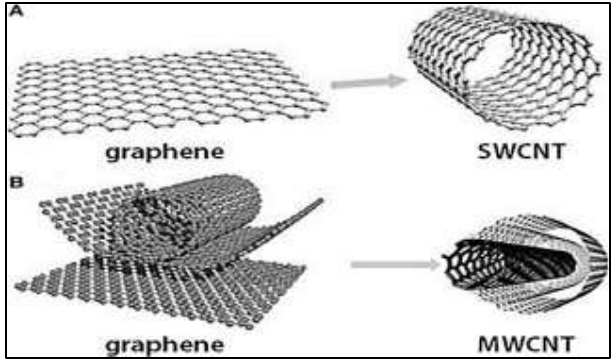
Figure 10: (A) single-walled, (B) multi-walled carbon nano-tubes